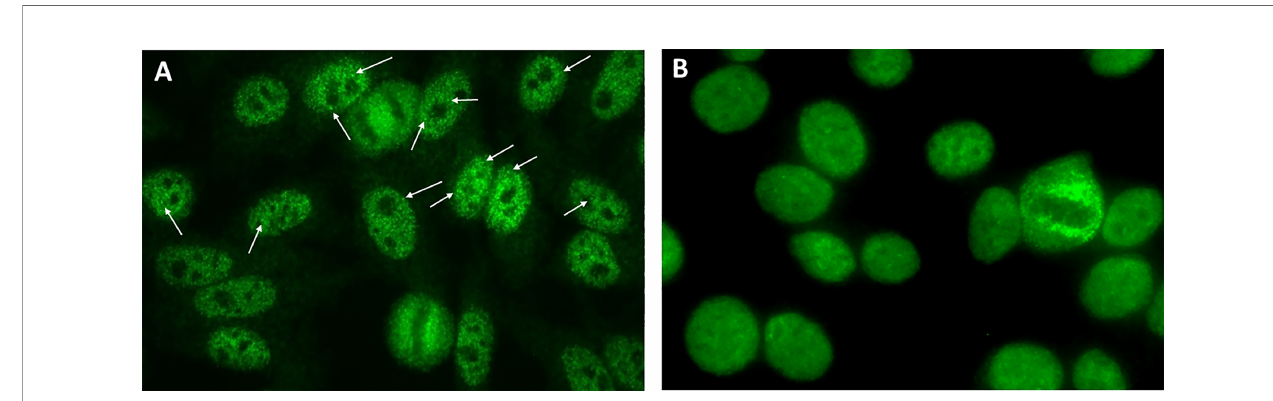
FIGURE 1 | Indirect immuno fl uorescence on HEp-2 cells showing the AC-4a and AC-4b patterns. (A) IUIS/ASC reference human serum for anti-SS-A/Ro IS2105 diluted 1/160 exhibiting the characteristic myriad discrete speckled nuclear AC-4a pattern (arrows, discrete tiny nuclear speckles); (B) Human serum with no reactivity to SS-A/Ro, diluted 1/160, exhibiting the characteristic plain nuclear fi ne speckled pattern (AC-4b) mostly lacking discrete speckles. Inova HEp-2 slide used. Magni fi